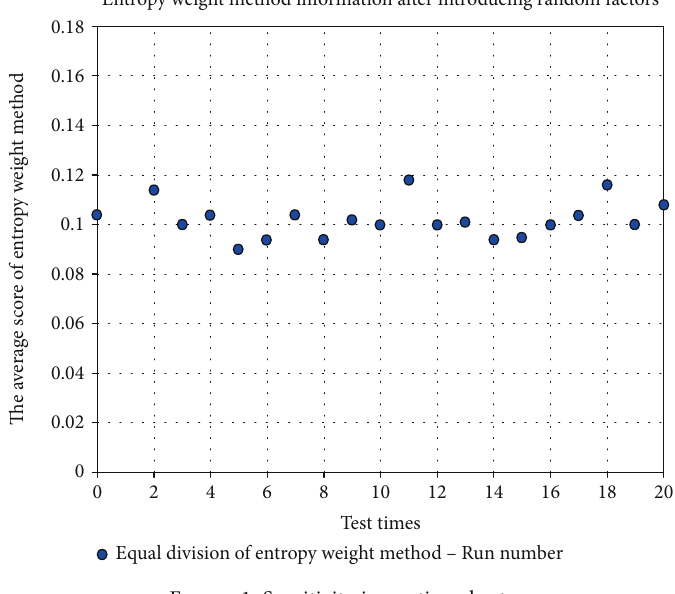
Figure 1: Sensitivity inspection